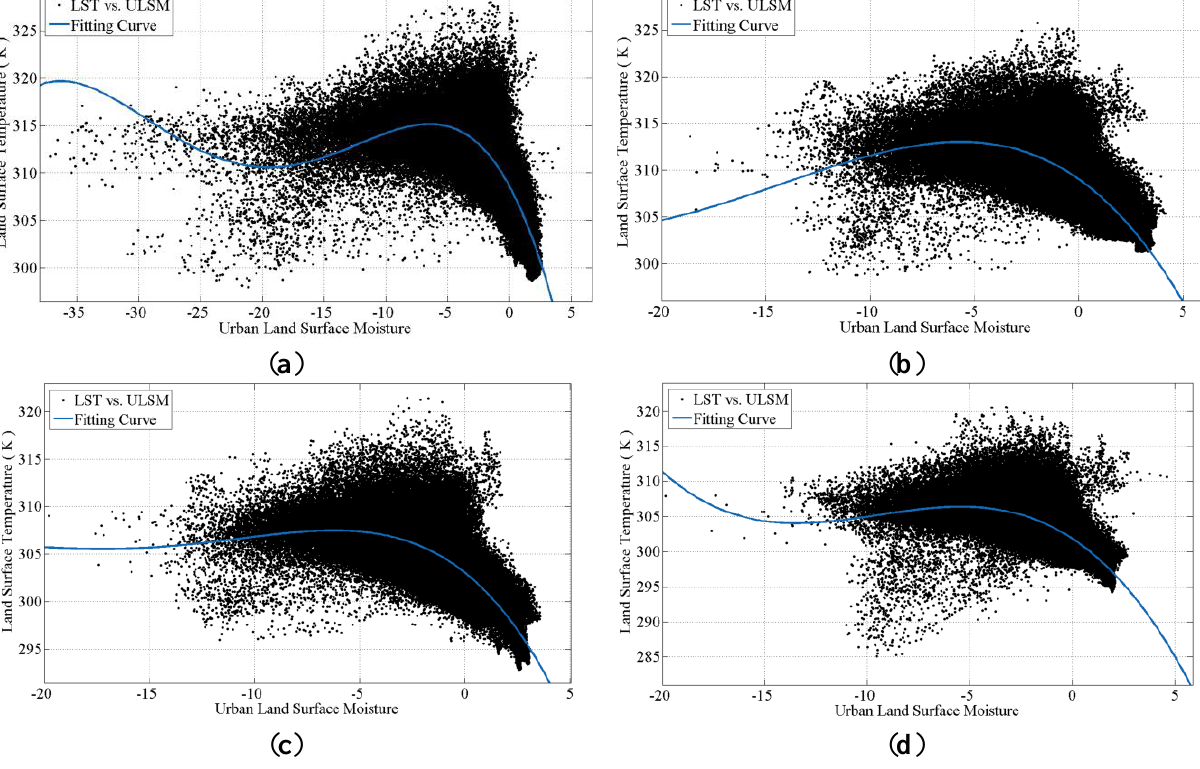
Figure 4. ( a ) 2D scatterplot of the LST vs. ULSM on 21 May 2013; ( b ) 03 September 2013; ( c ) 01 May 2014; ( d ) 22 September 2014. The blue curve is the fitting curve of polynomial fitting of degree